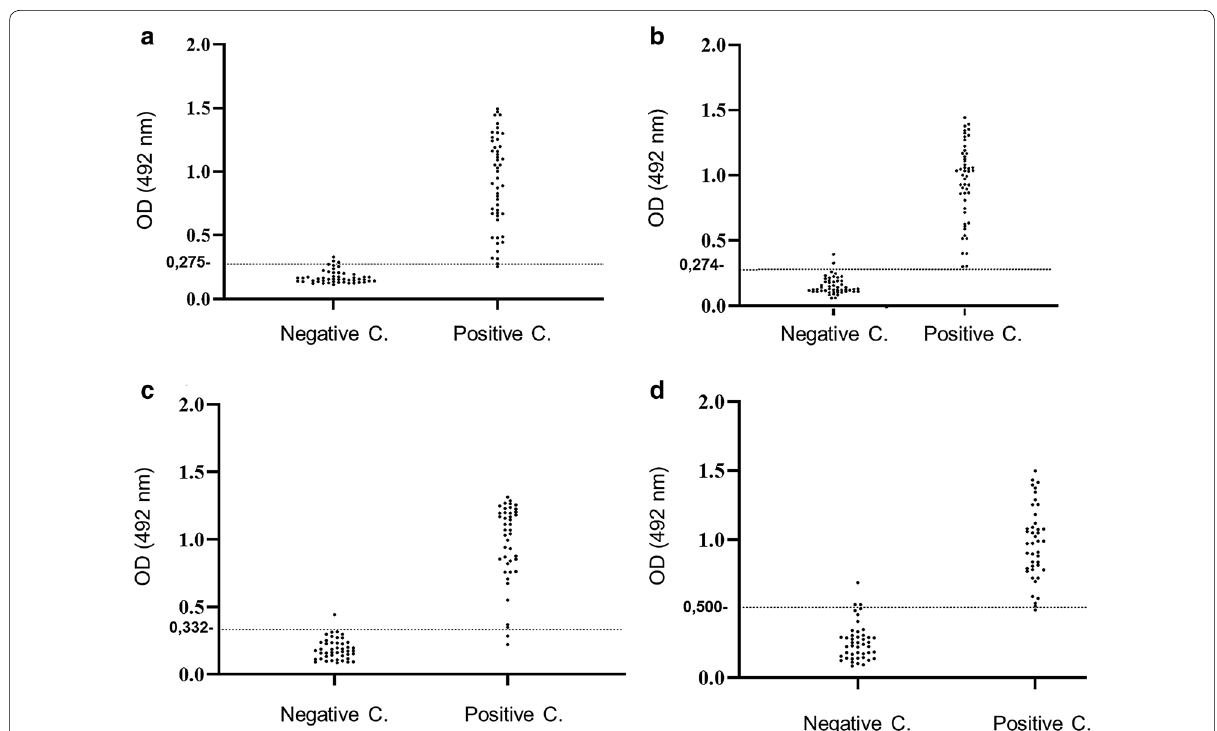
Fig. 2 Distribution of OD results from negative and positive control serum samples evaluated by ELISA using rSodC protein antigens and secreted C. pseudotuberculosis antigens. a ELISA-rSodC with goat sera, b ELISA-secreted C. pseudotuberculosis antigens with goat sera, c ELISA-rSodC with sheep sera and d ELISA-secreted C. pseudotuberculosis antigens with sheep sera. The graphs show the OD values obtained for each positive or negative sample. The lines in the graphs represent the cut-off value for each